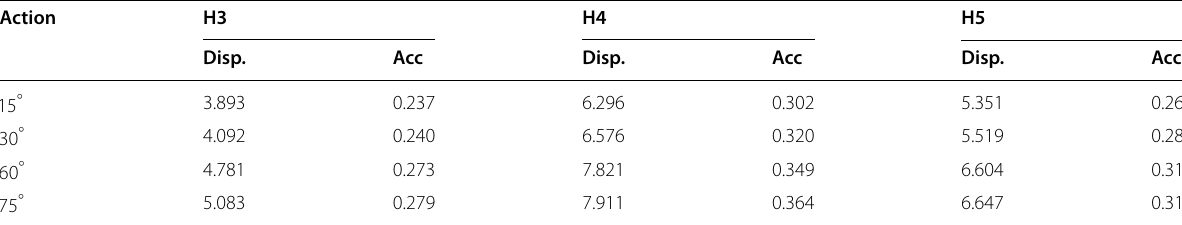
Table 5 Peak relative displacement and peak